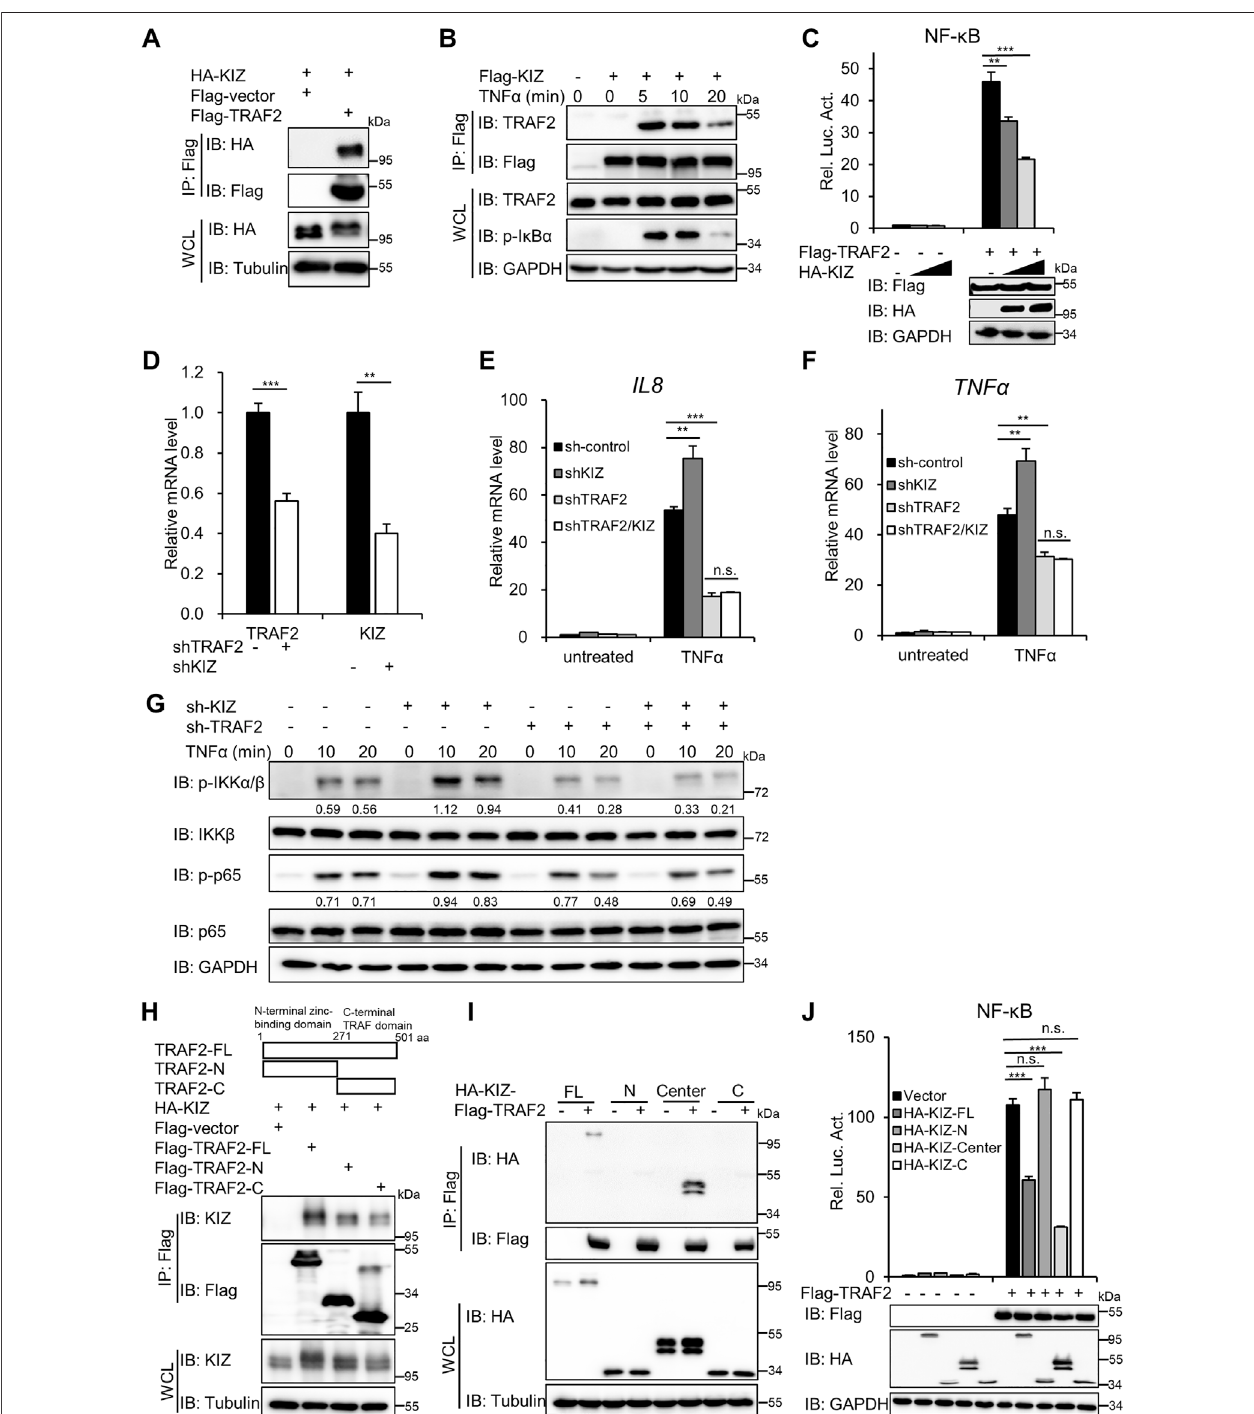
FIGURE5| KIZregulatesTNF α -inducedNF- ĸ BactivationbytargetingTRAF2. (A) HEK293Tcellsweretransfectedwiththeindicatedexpressionplasmids.At24 h aftertransfection,celllysatesweresubjectedtoCo-IPwithanti-Flagbeadsandanalyzedbyimmunoblotting. (B) HEK293TcellsweretransfectedwithaFlag-taggedKIZ expression plasmid or an empty vector. After 24 h, the cells were stimulated with TNF α (20 ng/ml) for the indicated times and then lysed for Co-IP with anti-Flag beads, followedbyimmunoblotting. (C) HEK293TcellsweretransfectedwithincreasingdosesofKIZplasmidsoranemptyvectortogetherwithaNF- κ B-Lucreporterand plasmids that expressed Flag-TRAF2 or an empty vector. After 24 h oftransfection, the cells were lysed for luciferase reporter assays (upper panel) and immunoblotting (lowerpanels). (D – G) U2OScellswereinfectedwithanshRNAlentivirusthattargetedKIZ,TRAF2,both,ortheemptyvectorfor48 h.Thecellswereuntreatedortreated